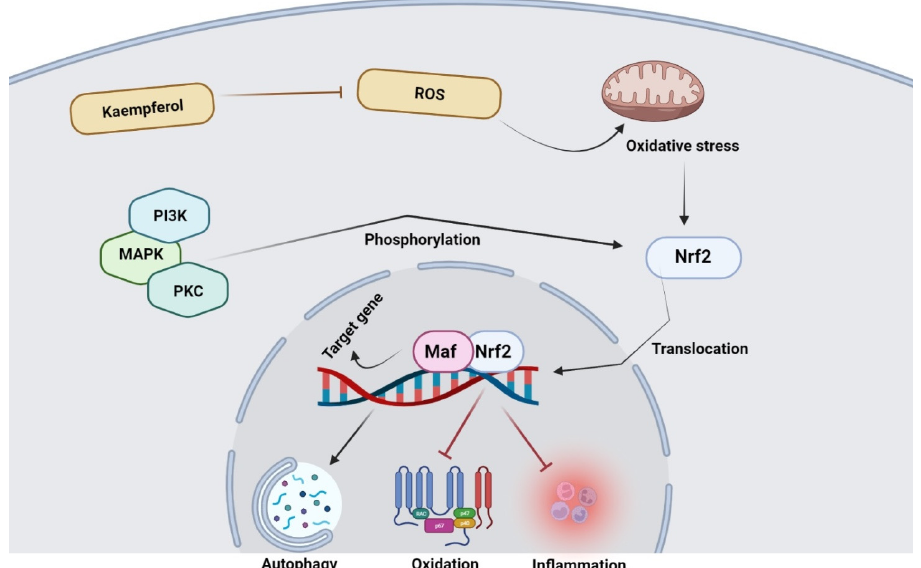
Figure 4. Kaempferol antioxidant potential via modulation of Nrf2. Reactive oxygen species metabolism is inhibited by kaempferol via acting on Nrf2 complex. After disintegration of the Nrf2 complex, it is translocated to the nucleus where it binds to Maf; as a result, the expression of target genes takes place, eventually causing the inhibition of inflammation, oxidation, and induction of autophagy.